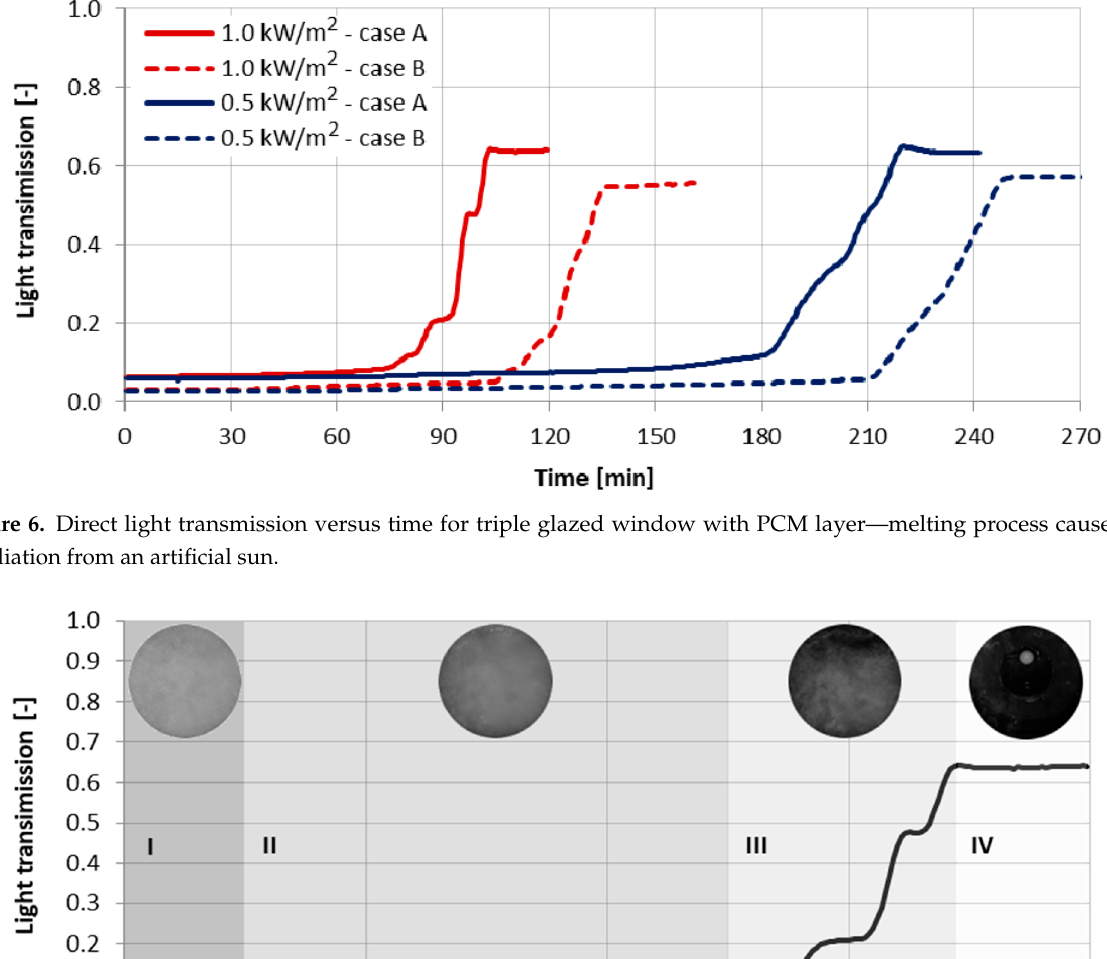
Figure 8. Direct light transmission versus time for an irradiance of 1000 W/m 2 , case B. Figure 9. Direct light transmission versus time for an irradiance of 500 W/m 2 , case A.